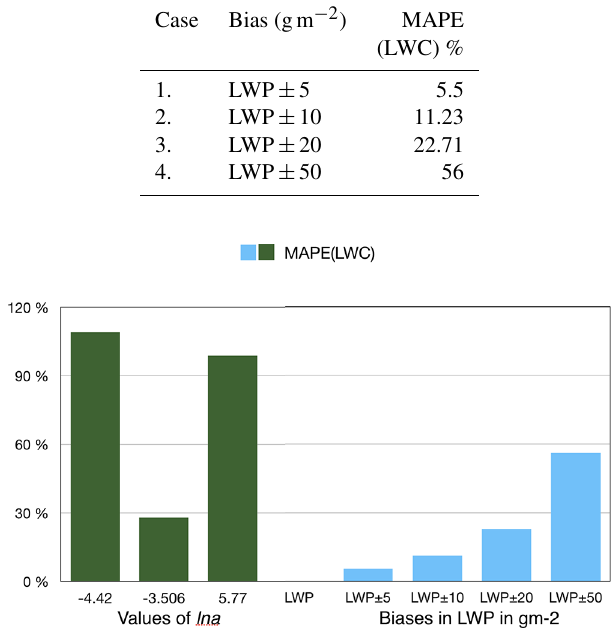
Figure 5. Errors in retrieved LWC when LWP is not assimilated (green bars), as compared to those when LWP is assimilated and affected by different values of biases (blue bars). The y axis rep- resents the MAPE in LWC, and the x axis shows the value of ln a taken from empirical relations and assumed biases in